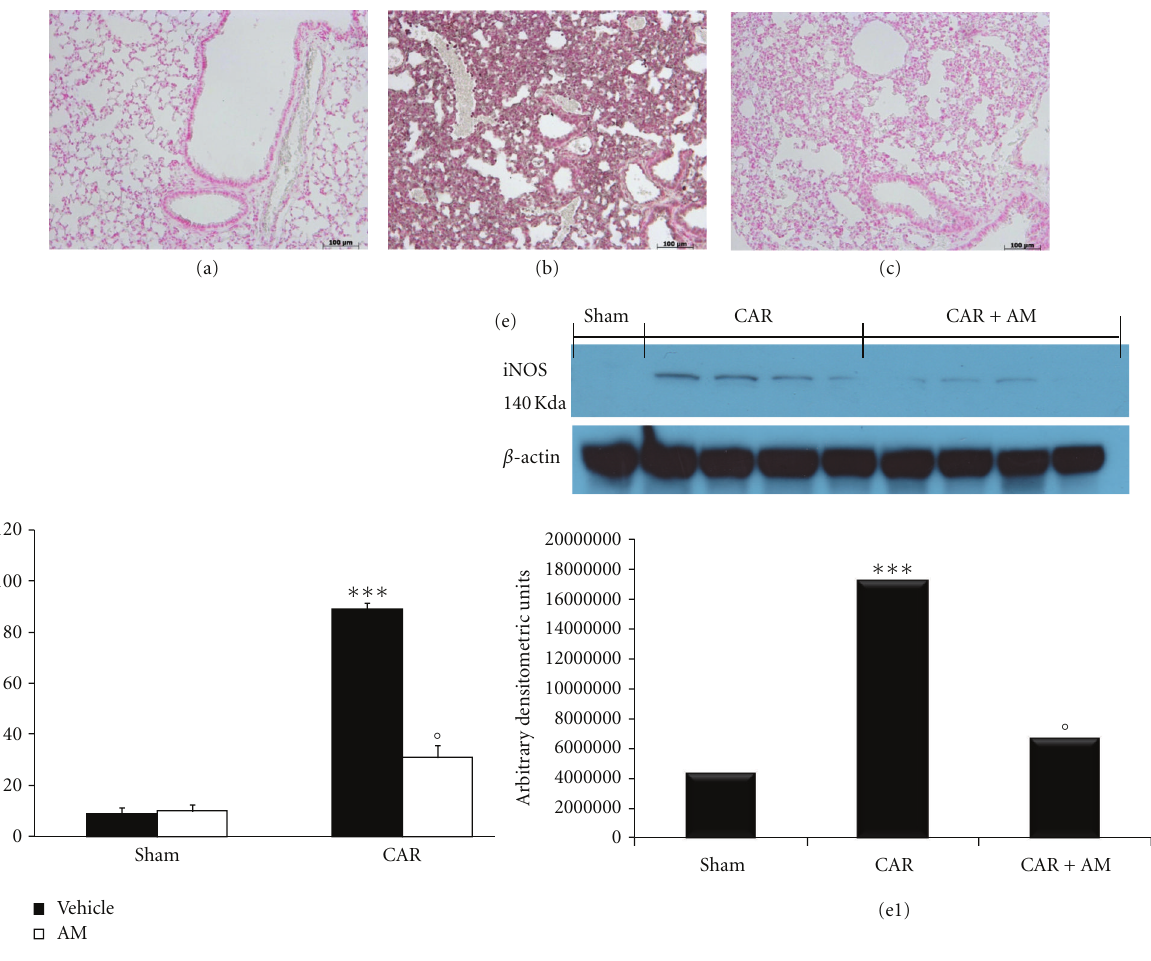
Figure 3: E ff ect of adrenomedullin (AM) on iNOS expression and NO formation. Lung sections taken from CAR-treated mice treated with vehicle showed positive staining for iNOS, localized mainly in inflammatory cells (b). The degree of positive staining for iNOS was markedly reduced in tissue sections obtained from mice treated with AM (c). Lung sections taken from sham mice showed no staining for iNOS (a). The figure is representative of at least 3 experiments performed on di ff erent experimental days. A significant increase in iNOS (e, e1) quantification, assayed by Western blot analysis, was detected in lungs obtained from mice subjected to CAR-induced pleurisy, if compared with lung from sham mice (e, e1). Treatment with AM significantly attenuated this protein quantification in the lung tissues (e, e1). A representative blot of lysates obtained from 5 animals per group is shown and densitometry analysis of all animals is reported. The results in panel (e1) are expressed as mean ± s.e.m. from n = 5 / 6 lung tissues for each group. ∗ P < 0 . 01 versus sham group. ◦ P < 0 . 01 versus CAR. Nitrite and nitrate levels, stable NO metabolites, were significantly increased in the pleural exudates at 4h after CAR (CAR) administration (d). AM significantly reduced the CAR-induced elevation of nitrite and nitrate in the exudates (d). Data are expressed as mean ± s.e.m. from n = 10 mice for each group. ∗ P < 0 . 01 versus sham group. ◦ P < 0 . 01 versus